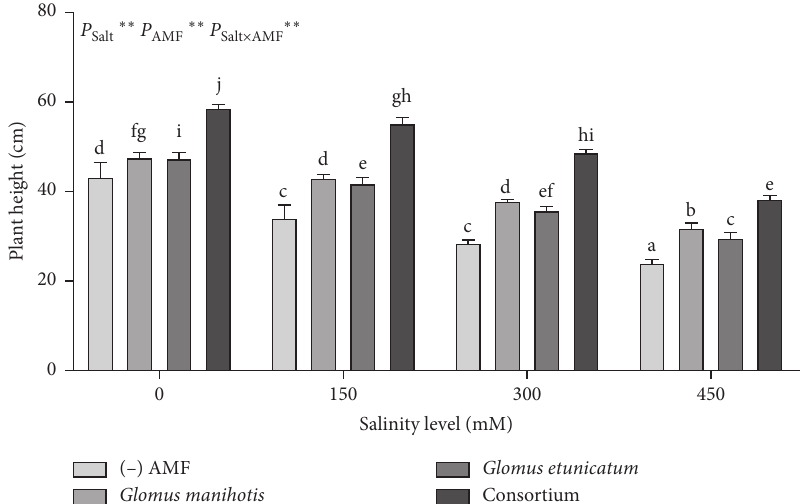
Figure 3: Effects of AMF inoculation on the height growth of L. leucocephala seedlings at different NaCl stress. AMF: arbuscular my- corrhizal fungi. ∗ : significant at 0.01 ≤ P ≤ 0 . 05; ∗∗ : significant at P ≤ 0 . 01. Bars that do not share a letter are significantly different at P ≤ 0 .